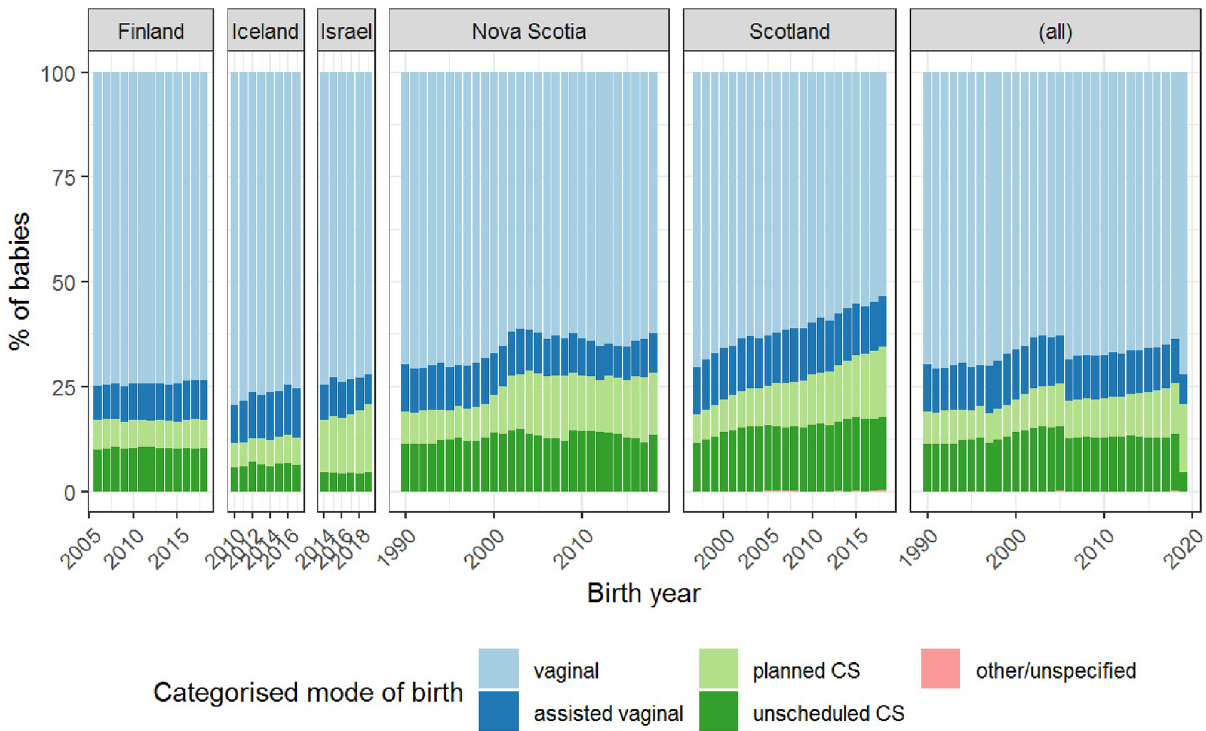
Fig 3. Modes of birth in the Co-OPT ACS cohort over time. Includes live births and stillbirths, and singleton and multiple births. The acute rise in proportion of vaginal births in the whole cohort (“all”) in 2006 reflects births in Finland joining the Co-OPT ACS cohort. The final year in the whole cohort panel (2019) contains data from Israel alone. CS = Caesarean section. (all) = All babies in the Co-OPT ACS